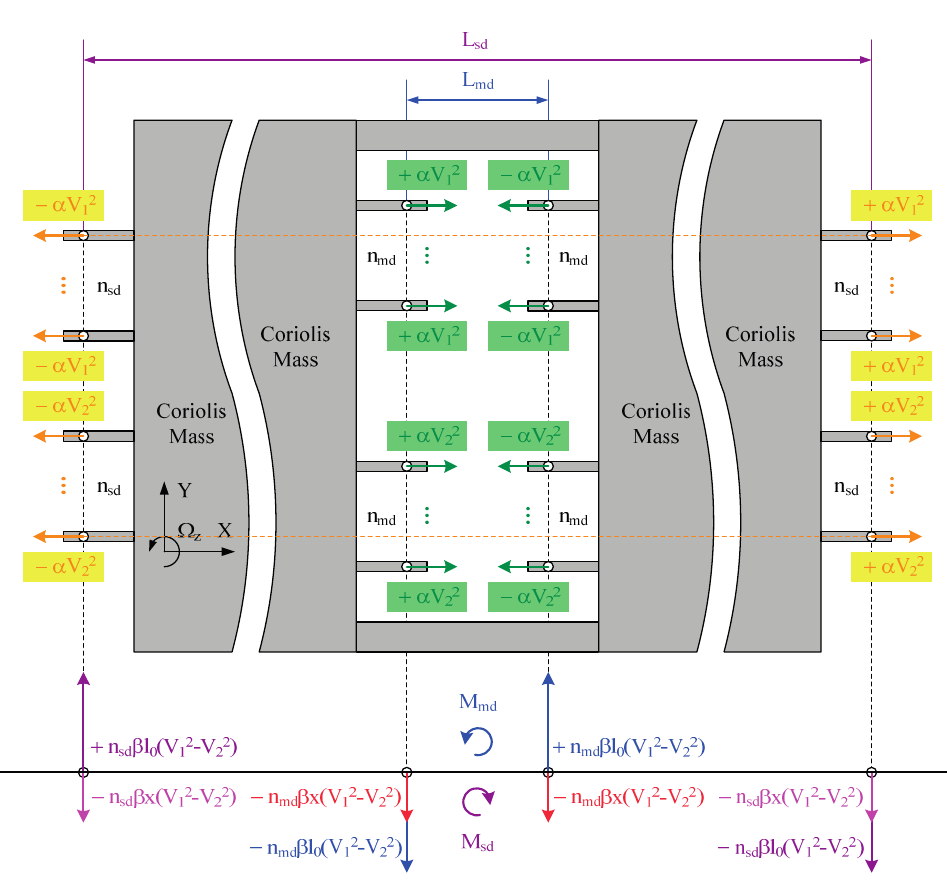
Figure 4. Force and torque distributions of the layout